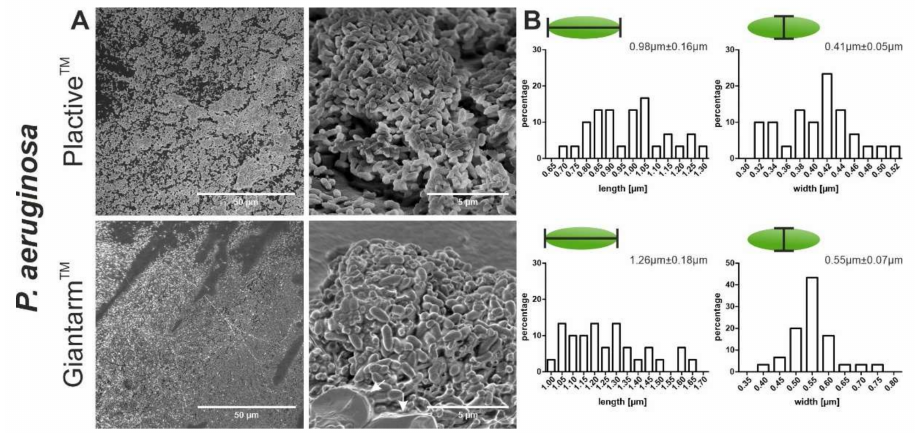
Figure 2. Scanning electron microscopy (SEM) images showing the biofilm formation and size measurement of P. aeruginosa . ( A ) The two top SEM images depict the formation of biofilm on Plactive™ PLA. The two bottom images depict the biofilm formation on Giantarm™ PLA. Slime formation is indicated by an arrow. ( B ) The two top graphs visualize the size distribution of the bacteria on Plactive™ PLA, and the two bottom graphs visualize the size distribution of the bacteria on Giantarm™ PLA. For all four graphs, the y axis represents the relative percentage and the x axis represents the length or width of the bacteria in